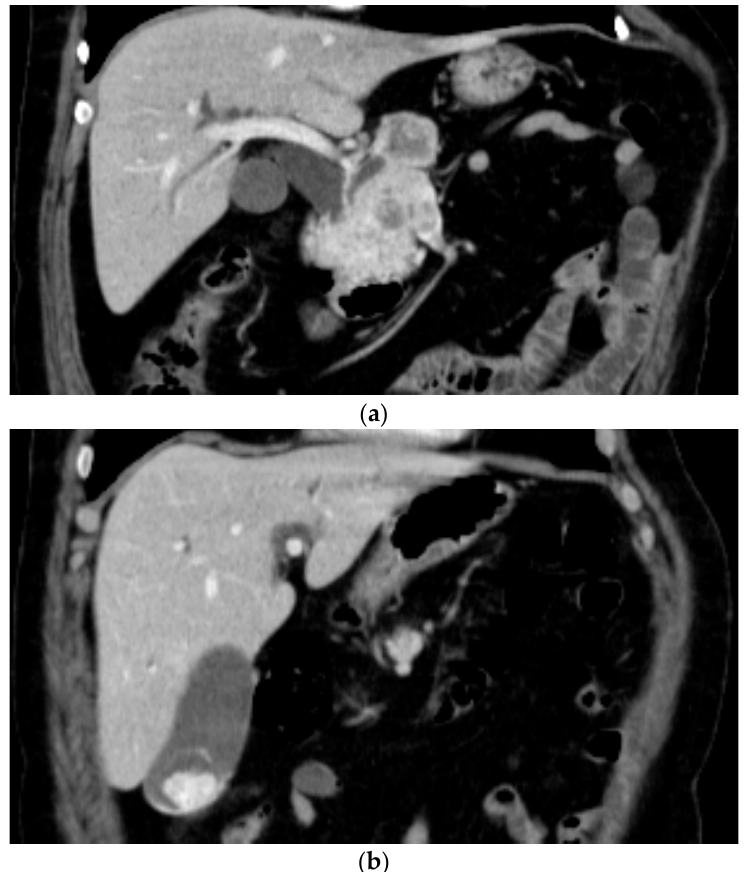
Figure 2. ( a ) Contrast-enhanced computed-tomography scan showing hyperenhancing mass in the head of the pancreas, with consecutive common bile duct dilation. ( b ) Contrast-enhanced computed-tomography scan showing hyperenhancing mass in the fundus of the gallbladder.